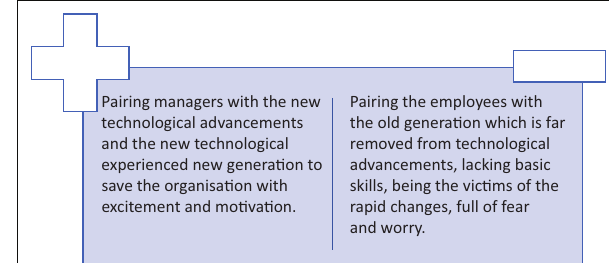
Managers in fight posi(cid:17)on: proac(cid:17)ve, excited, mo(cid:17)vated and empowered. Skilled to drive the 4IR processes